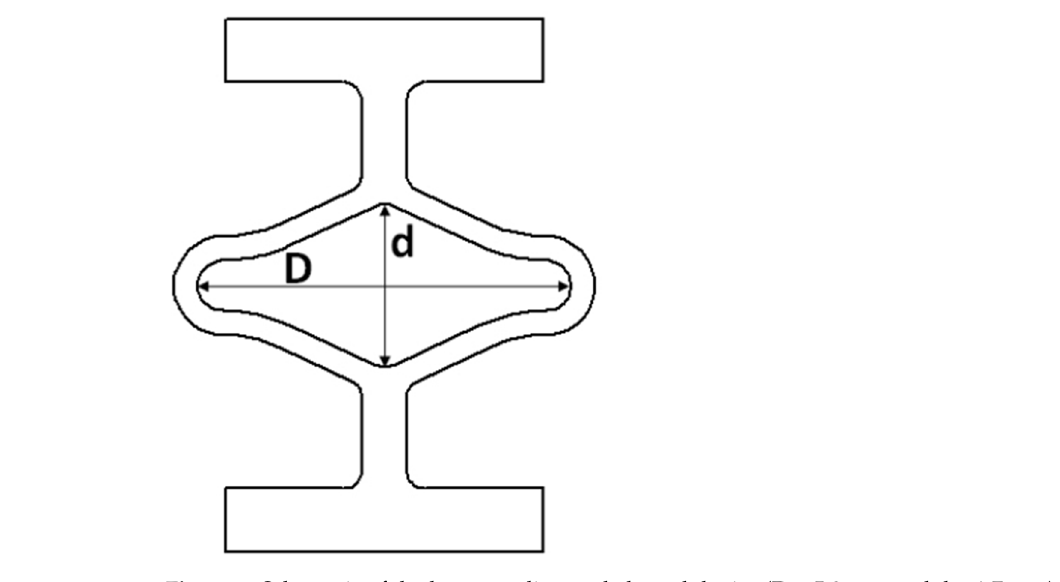
Table 2. Process–ability map indicating the realisation of complete through-cut edges (represented by X) and blind-cutting edges (represented by O) while varying the investigated process parame- ters.